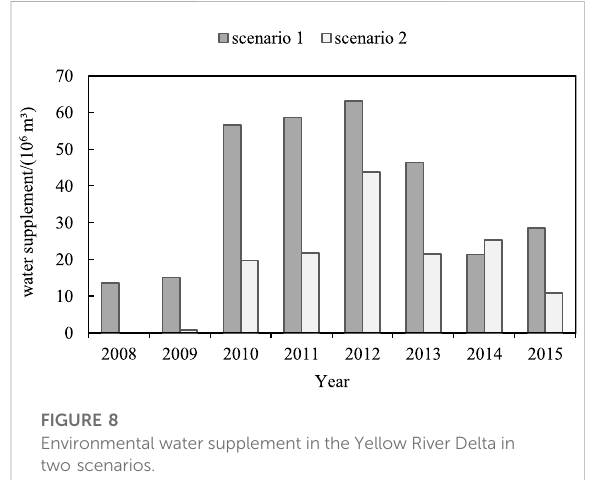
FIGURE 8 Environmental water supplement in the Yellow River Delta in two